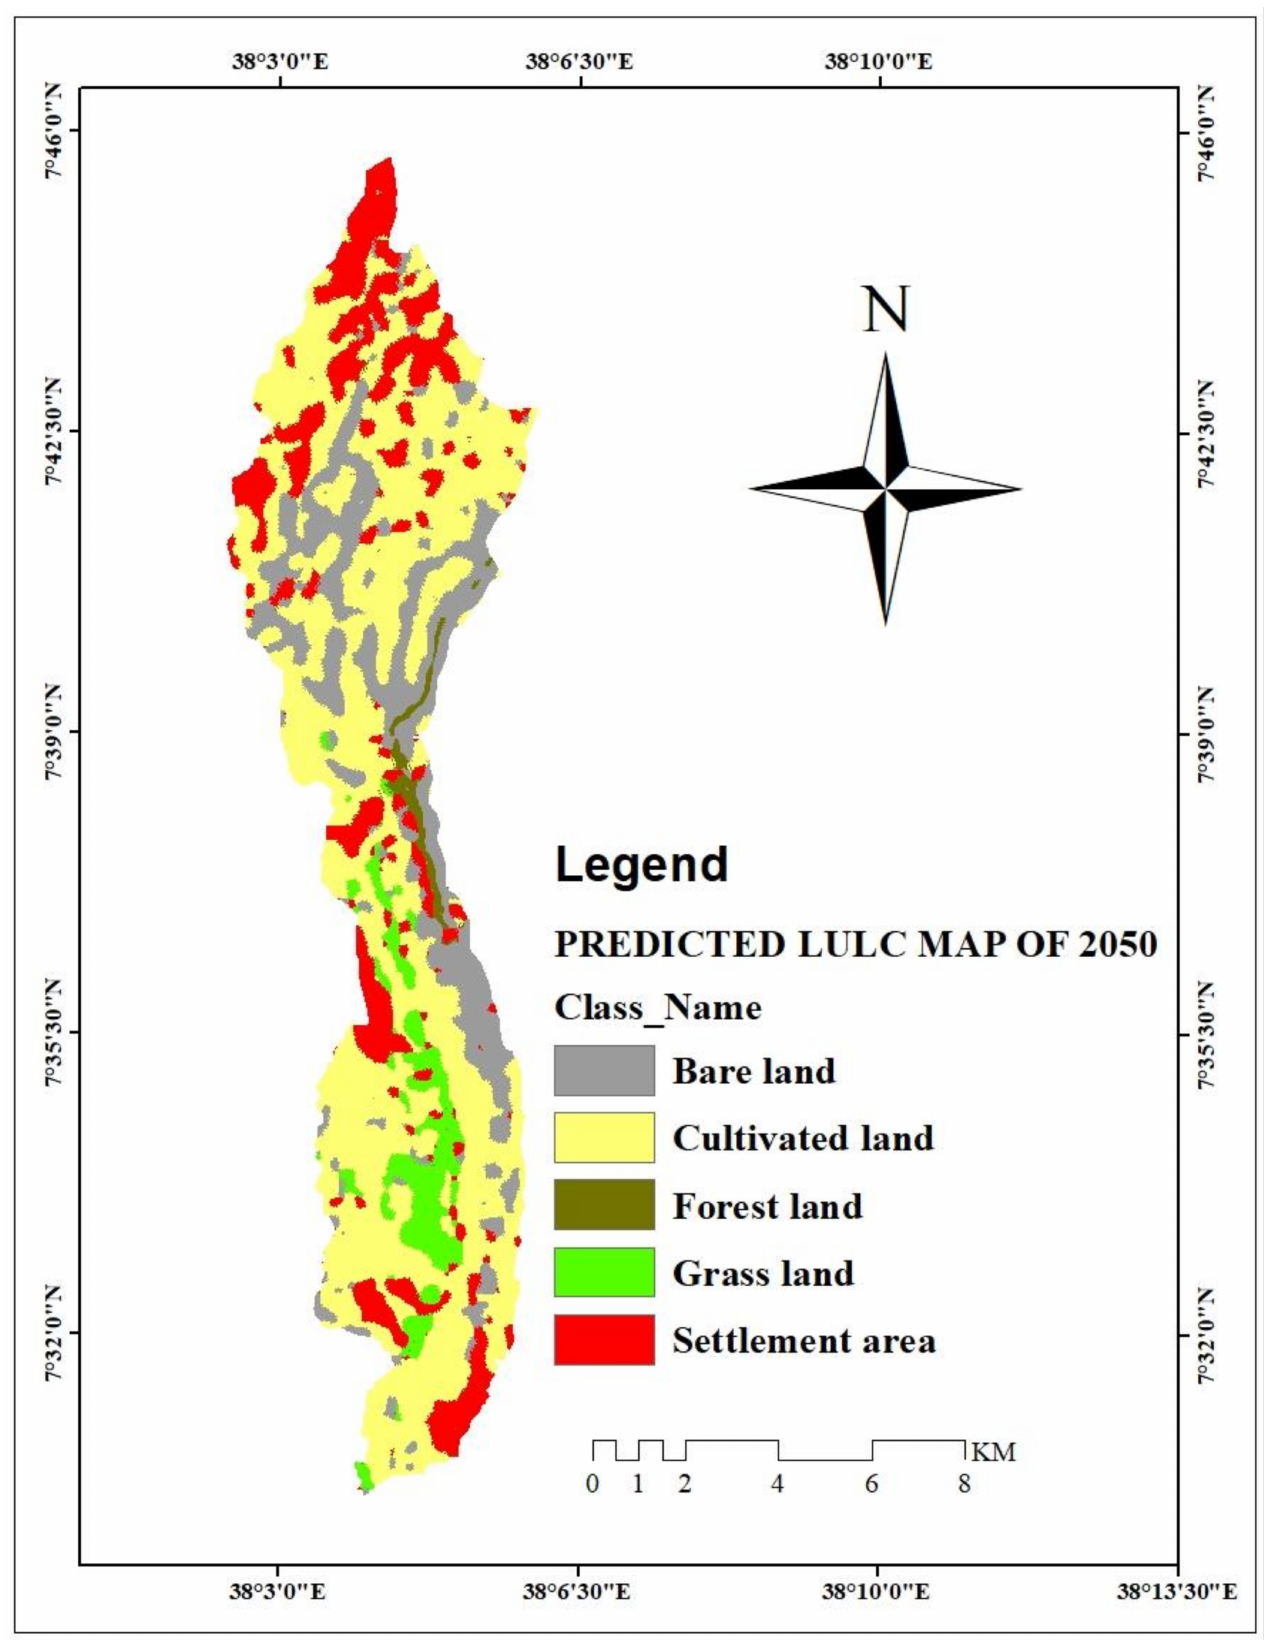
Figure 10. The LULC map of Matenchose watershed predicted for in